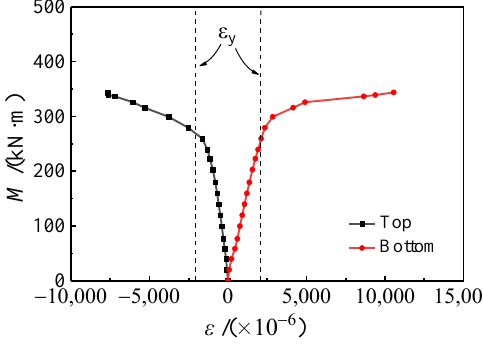
Figure 12. Moment versus top and bottom surface strain of S-6.